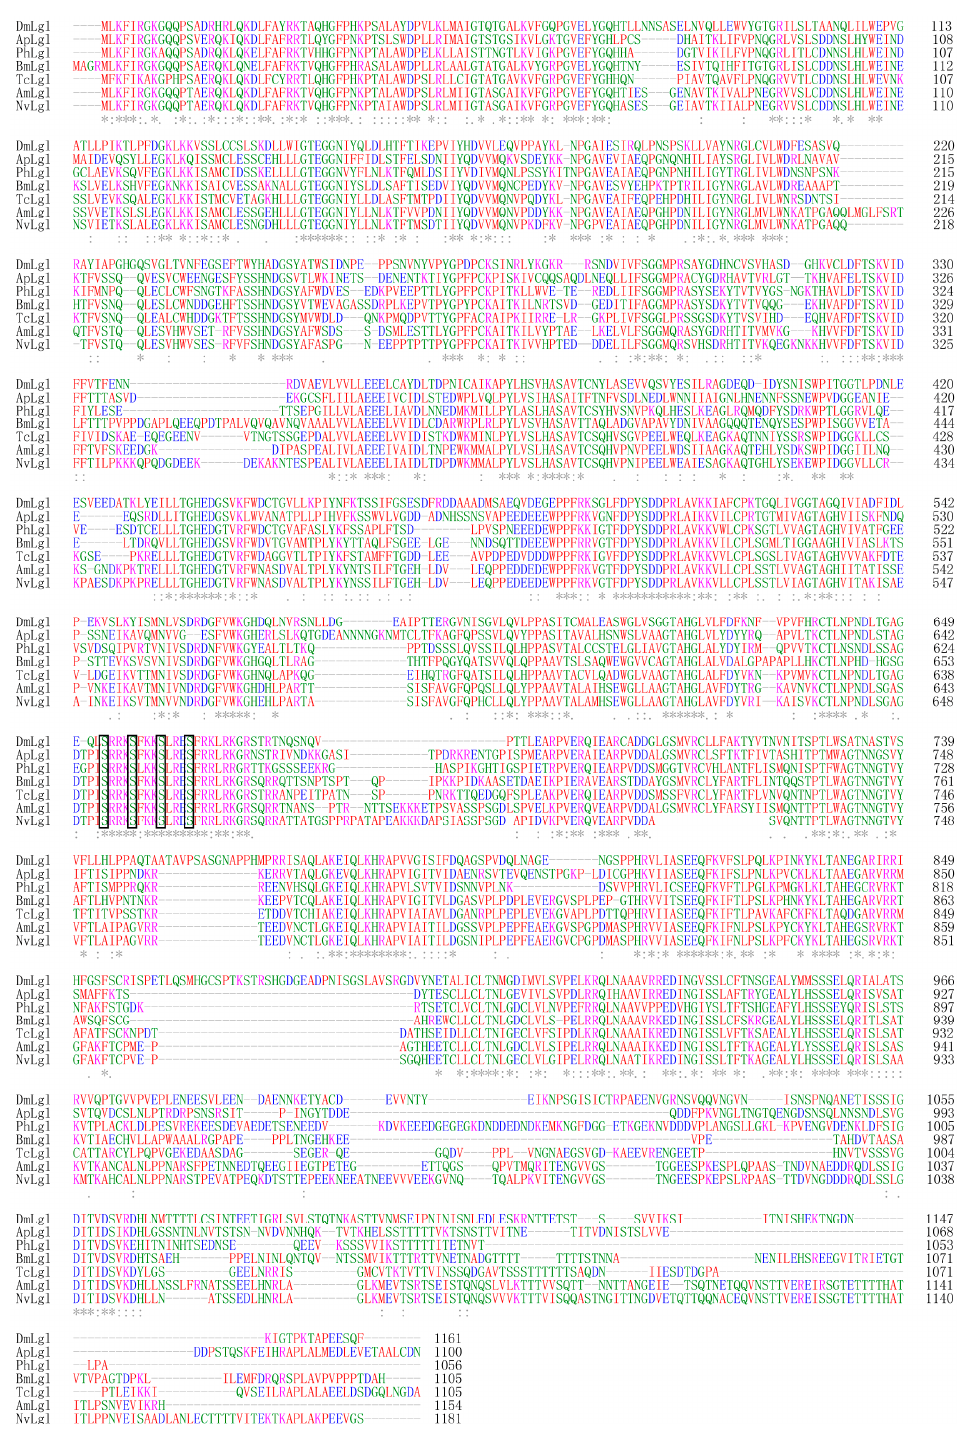
Figure 2. Alignment of deduced Lgl protein sequences from seven representative insect species, including DmLgl (AAG22255.1, D. melanogaster Lgl); ApLgl (XP_001948718.2, A. pisum ); PhLgl (EEB15731.1, P. humanus corporis ); BmLgl (XP_004921966.1, B. mori ); TcLgl (KJ434293, T. castaneum , this paper); AmLgl (XP_003249432.1, A. mellifera ); and NvLgl (XP_001604186.2, N. vitripennis ). Numbering of the amino acid sequences is all started from the N -termini of their predicted mature proteins. Identical amino acid residues are indicated by asterisks and conservative substitutions are shown by dots. The conserved serine phosphorylation sites are